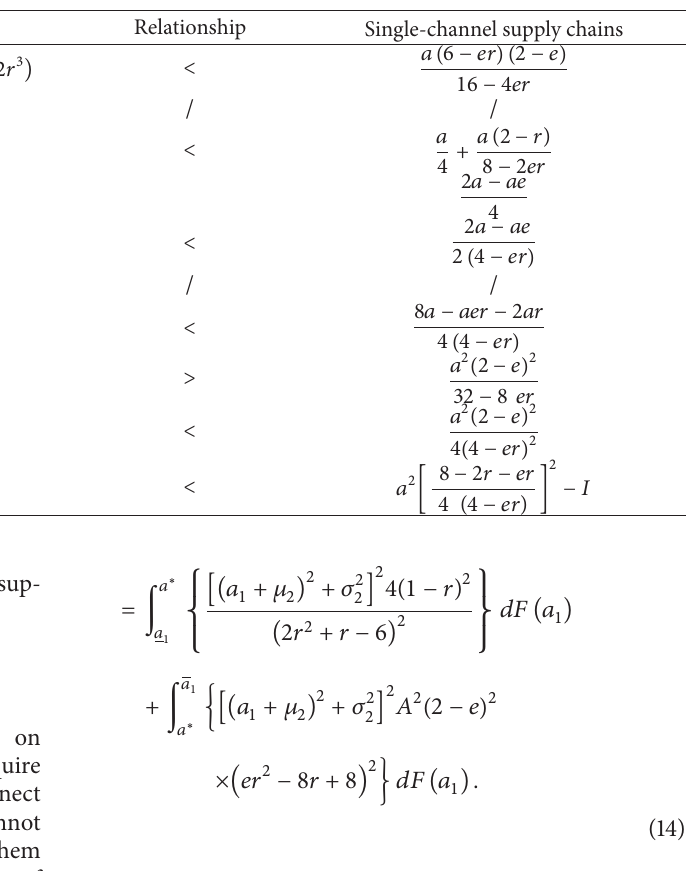
Table 1: Comparison results between single-channel and double-channel supply